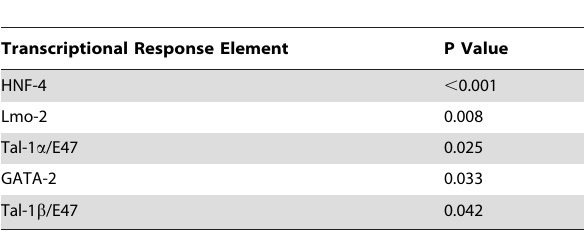
Table 5. MAM-associated enriched transcription factor binding sites.